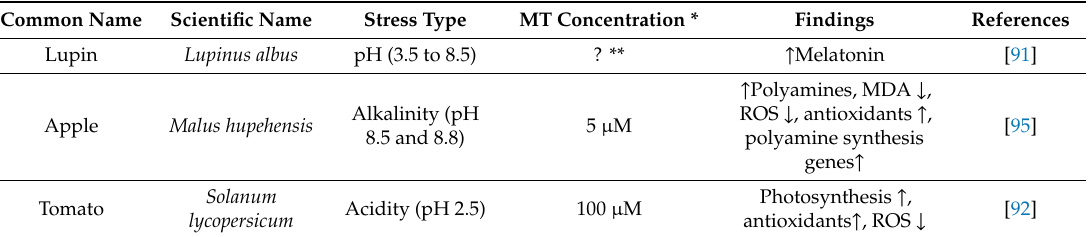
Table 2. The action of melatonin in mitigation of pH stress